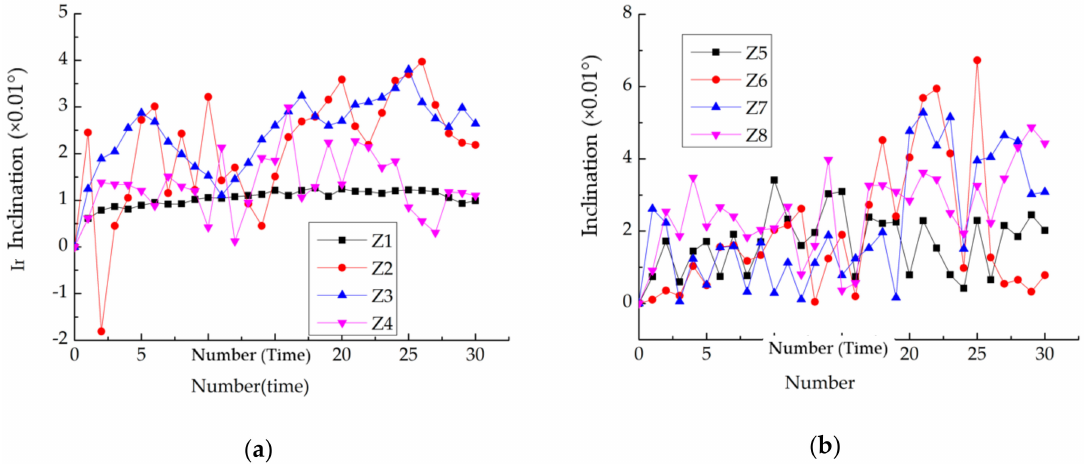
Figure 17. Column inclination measurement curve: ( a ) Z1–Z4 inclination measurement curve; ( b ) Z5–Z8 inclination measurement